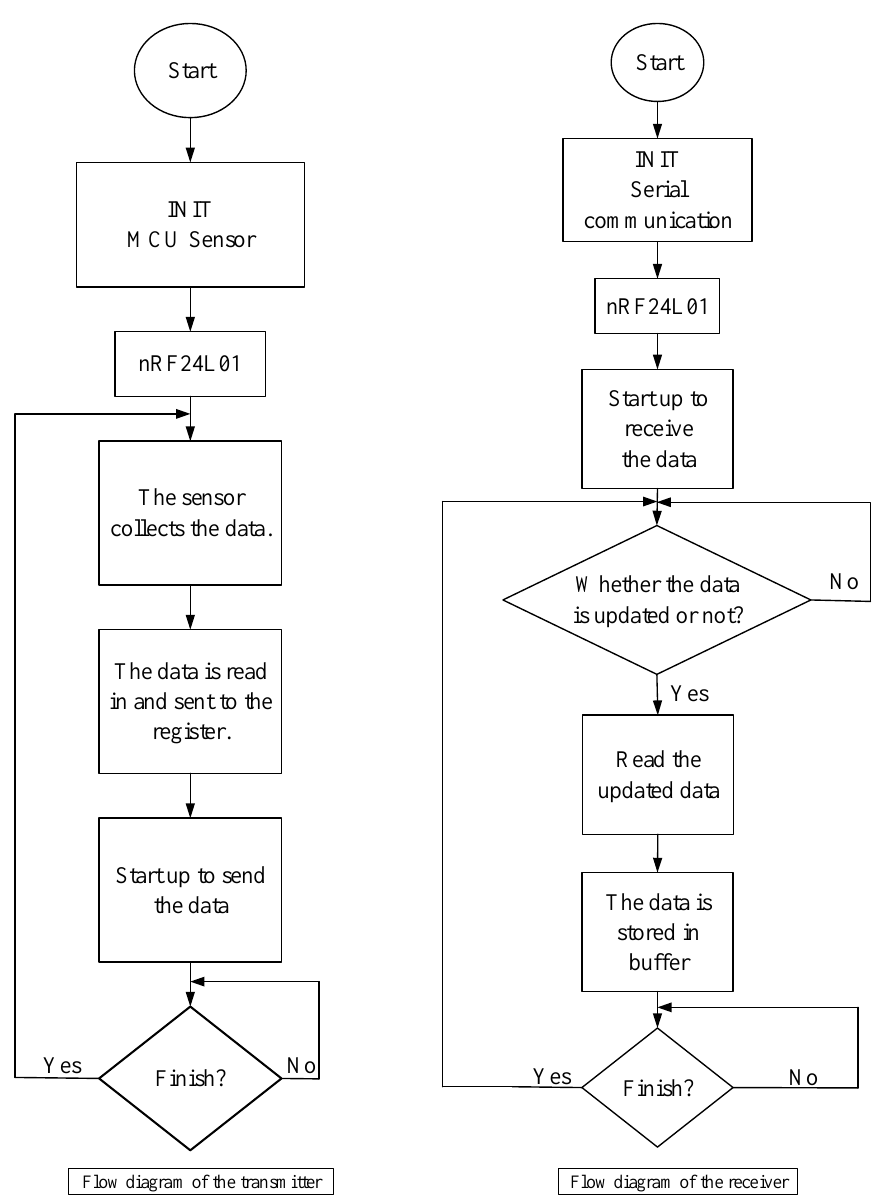
Figure 6. Flow diagram of the